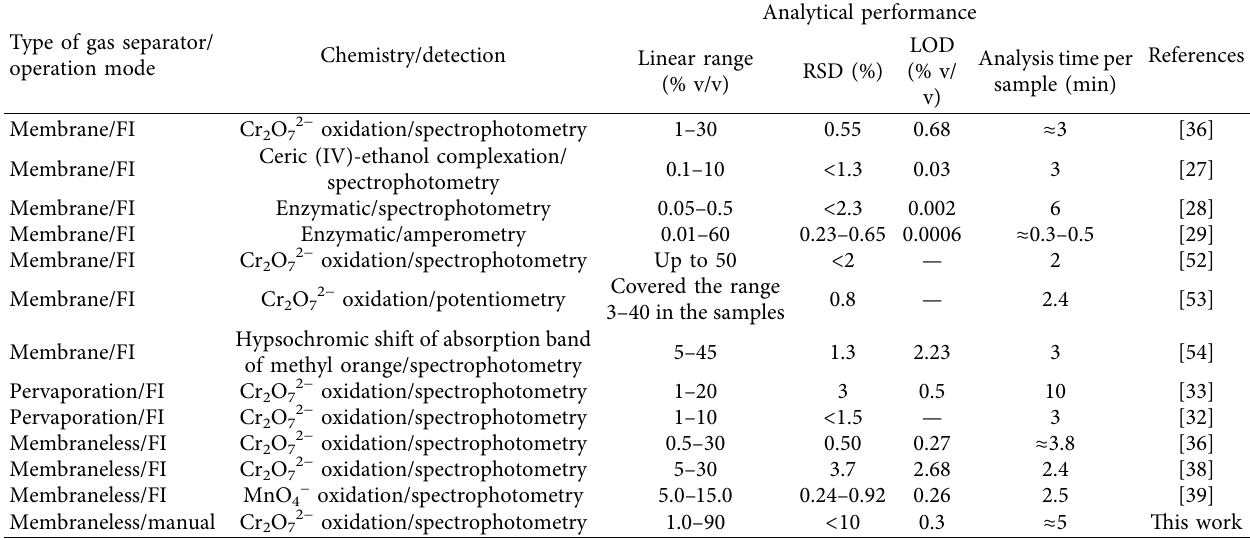
Table 1: Some analytical performance of the proposed MBL-VP unit and the previous MGD